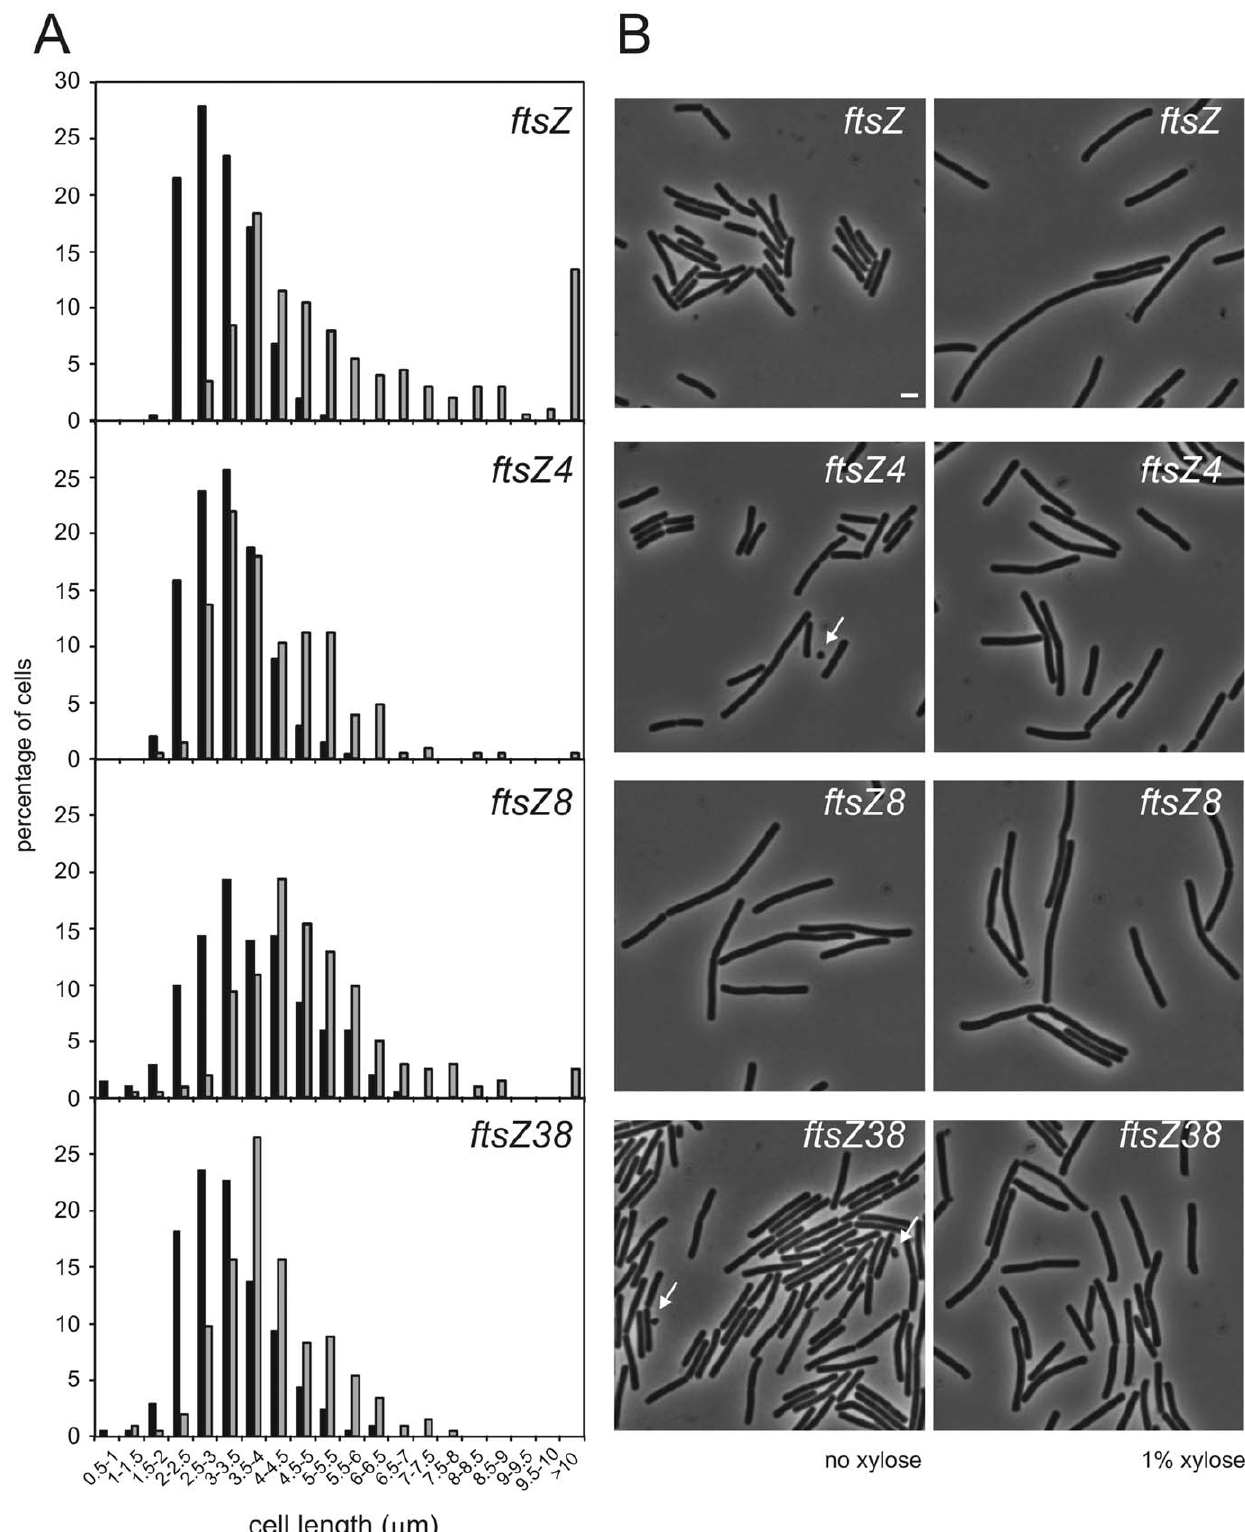
Figure 1. GFP-MinC/MinD overexpression leads to filamentation in cells expressing wild type FtsZ, but not in cells expressing FtsZ mutants. (A) Length distributions are shown of strains expressing either wild type or mutant ftsZ , after dilution of exponentially growing cells into fresh growth medium with (grey bars) or without (black bars) 1% Xylose to induce GFP-MinC/MinD overexpression. Cells were labelled with FM4.64 after 3.5 hours, incubated for another 30 minutes, fixed and processed for microscopy. Cell lengths were determined and grouped in length classes of 0.5 m m (more than 200 cells for each condition).(B) Phase contrast images of the cells used for the length distributions depicted in (A). Scale bar (same for all): 2 m m. Arrows indicate minicells. doi:10.1371/journal.pone.0012048.g001 PLoS ONE |